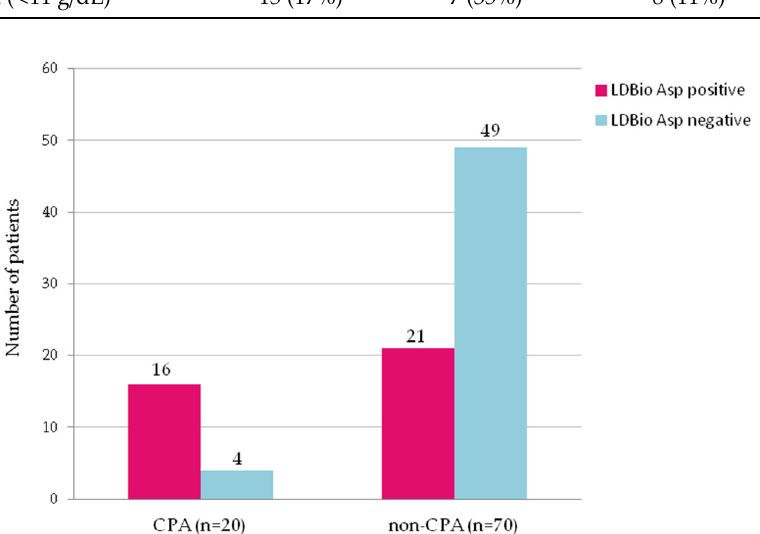
Figure 3. Rates of positivity for serum IgG-IgM Aspergillus antibody tested by LDBio Aspergillus immunochromatography in 20 patients with chronic pulmonary aspergillosis (CPA) and 70 non-CPA patients with history of pulmonary tuberculosis. The positivity rate in CPA group and in non-CPA group was 80% and 30%, respectively ( p < 0.001).